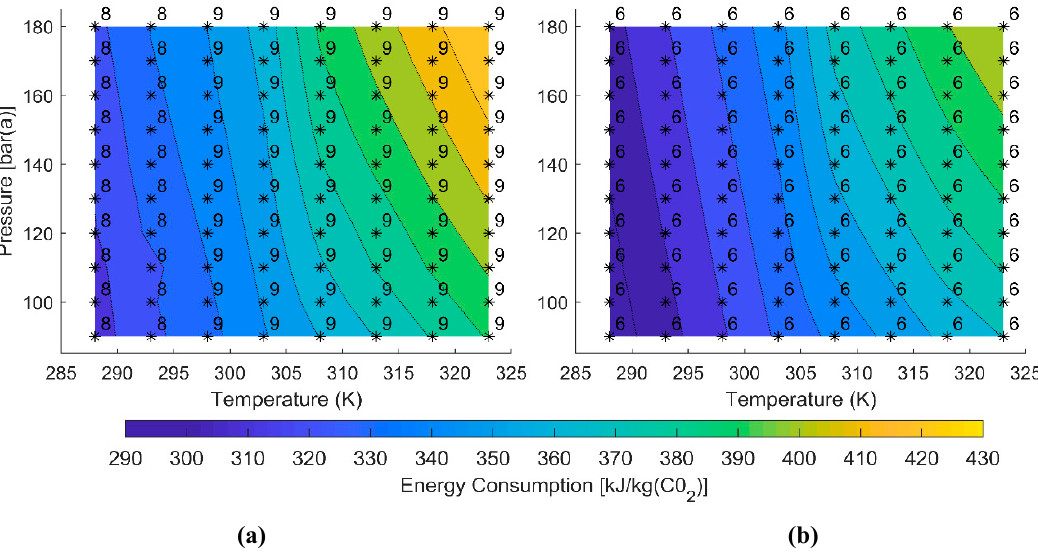
Figure 8. Pre-combustion capture cases, optimized compression energy consumption and number of stages, (a) constrained cases and (b) unconstrained cases.